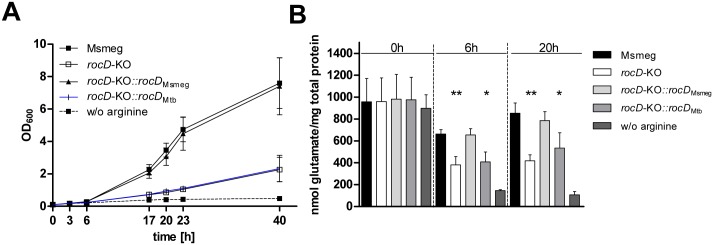
Growth (A) and glutamate formation (B) of a rocD mutant in Msmeg cultured on arginine as nitrogen source.Msmeg wild type (Msmeg), Msmeg knockout mutant for rocD (rocD-KO), the Msmeg rocD-KO mutant complemented with rocD wild type gene from Msmeg (rocD-KO::rocD
Msmeg), and the Msmeg rocD-KO mutant complemented with rocD wild type gene from Mtb (rocD-KO::rocD
Mtb) are shown. All strains were cultured for 40 hours in minimal medium with glycerol and glucose as carbon sources and with 5 mM of arginine as a sole nitrogen source (solid line). Msmeg wild type was also cultured without arginine as a control (broken line). A) Growth was analyzed measuring absorbance (OD600) at 3h, 6h, 17h, 20h, 23h, and 40h. Mean values and standard deviations are shown for three independent biological experiments. B) Intracellular glutamate was determined in bacterial cell extracts after 0, 6, and 20 hours of growth. Mean values and standard deviations are shown for three independent biological experiments, p- values were calculated using student’s t test (* p < 0.05, ** p < 0.01).